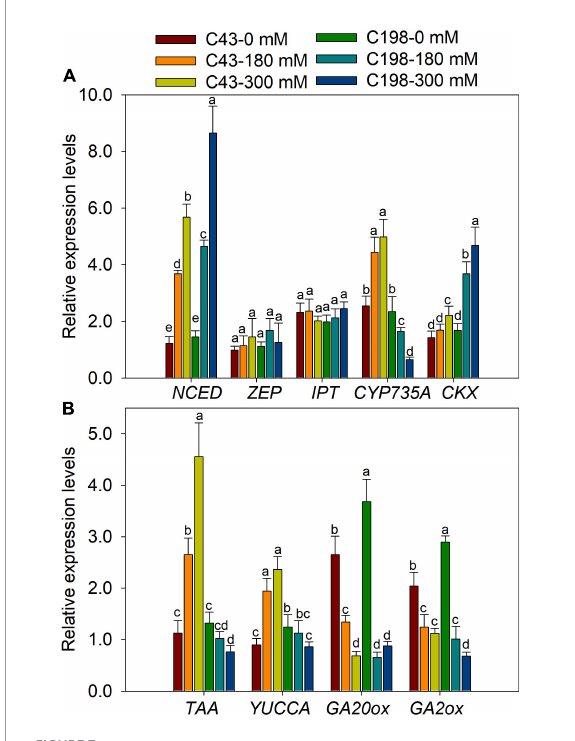
FIGURE7 Gene expression levels in roots of the two bermudagrass genotypes differing in salt tolerance (C43: tolerant; C198: sensitive). (A) genes related to ABA and cytokinin biosynthesis; (B) genes relate to auxin and GA biosynthesis. Bars marked by the same letters are not significant at P < 0.05 (Tukey’s test) for the comparison of different treatments. Data represent the mean ± SD of four independent biological replicates.